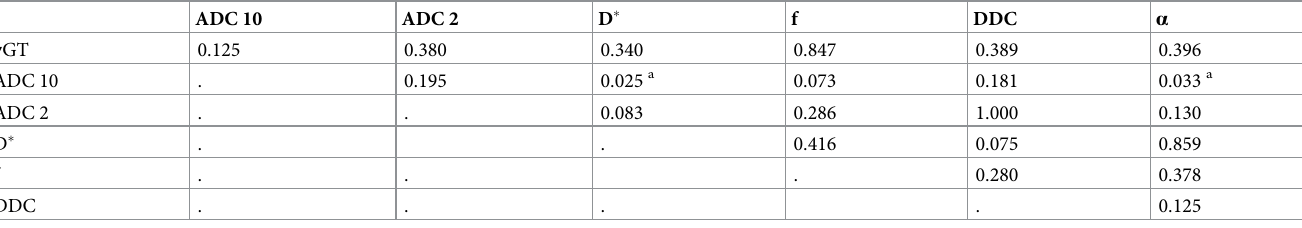
Abbreviations: BA = Biliary atresia, ROC = Receiver operating characteristic, γ GT = γ -glutamyl transferase, ADC = Apparent diffusion coefficient, D � = Fast pseudo- diffusion from microcirculation and perfusion, f = Perfusion fraction, DDC = Distributed diffusion coefficient, α = Heterogeneity index. a P-value <